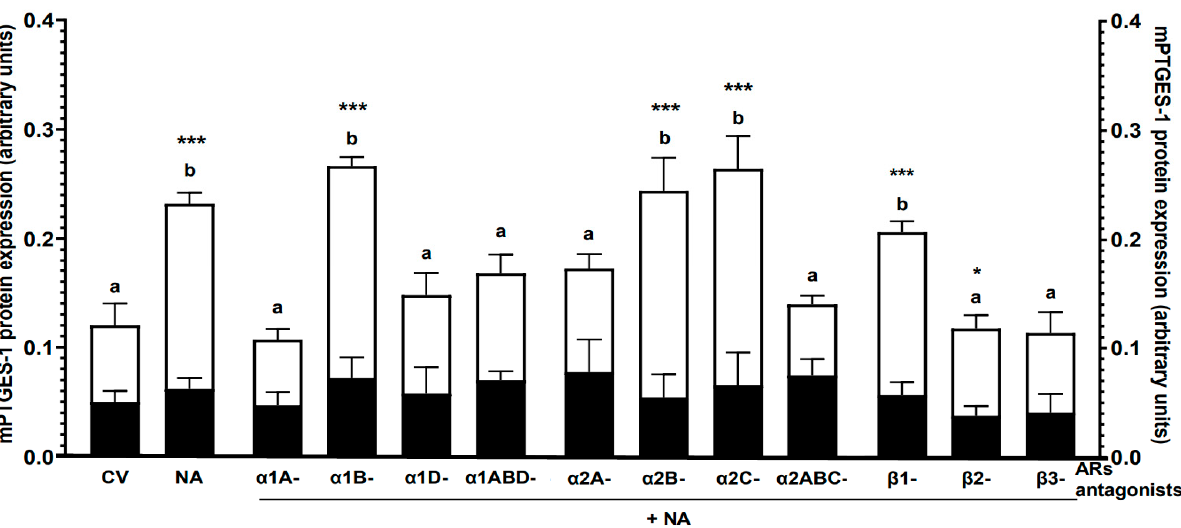
Figure 2. Effects of noradrenaline (NA, 10 − 5 ) alone or antagonists of α 1-, α 2- and β -ARs (10 − 4 M) with noradrenaline on the mPTGES-1 protein expression in the pig endometrium of the CON (black bars) and E. coli (white bars) groups, estimated by western blot method. Treatments were performed in triplicate for each of the five gilts in the individual groups. Values for mPTGES-1 were normalized to ACTB. Results are expressed as the mean ± sem. Blots with representative bands for each group are presented in Supplementary Figure S2. Different letters (a, b) indicate statistical differences ( p < 0.05–0.001) within each group for each subtype of α 1- or α 2-AR antagonists with noradrenaline or class of β -AR antagonists with noradrenaline and in relation to the control value (CV, untreated tissue) and noradrenaline action alone; *, *** indicate statistical differences ( p < 0.05, p < 0.001) between groups for the same treatment.